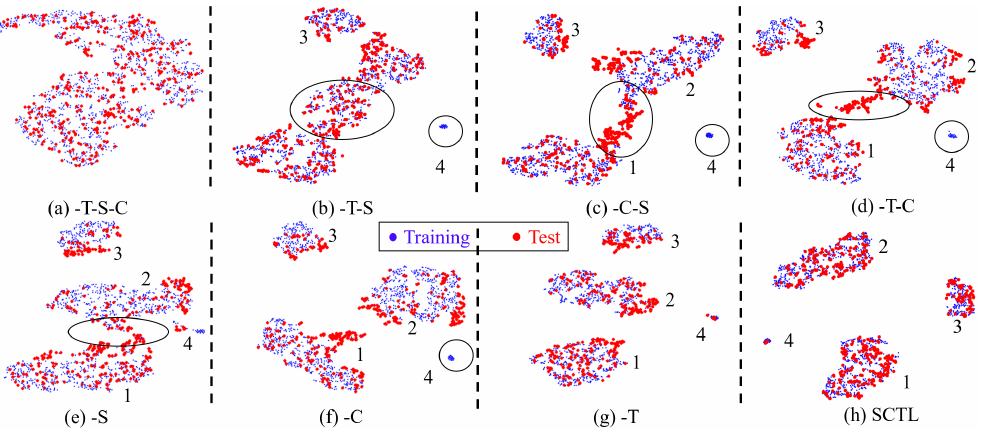
Figure 7. t-SNE view of training and test dataset with different loss functions. Blue color represents training dataset and red represents test dataset. Numbers 1 to 4 mean the location of four classes (Score 1 to Score